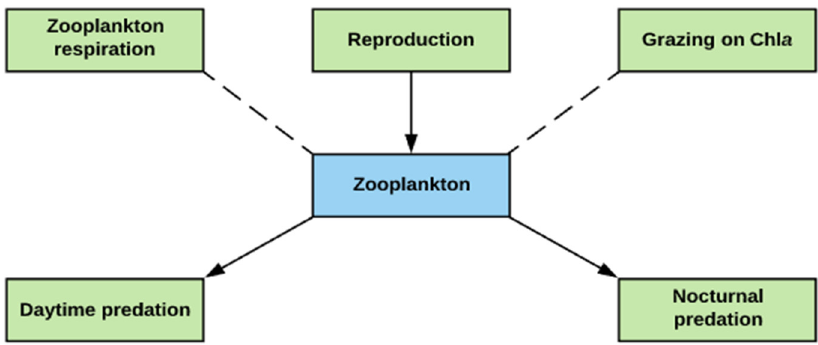
Figure 2. Schematic diagram of zooplankton cycle modeled by MINLAKE2020.